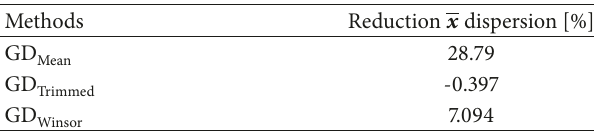
Table 46: Contaminated 𝜒 2 with 20 points.